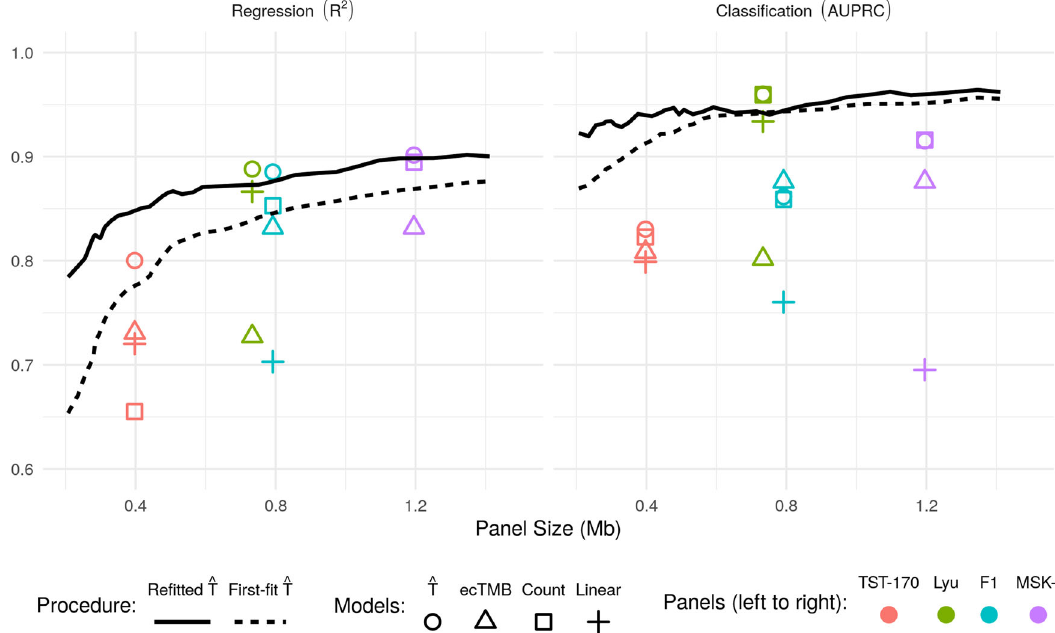
Fig. 3 Comparison with existing estimators. The performance of our TMB estimator in comparison to existing approaches. Left: R 2 , Right: AUPRC. COMMUNICATIONS BIOLOGY| (2022) 5:156